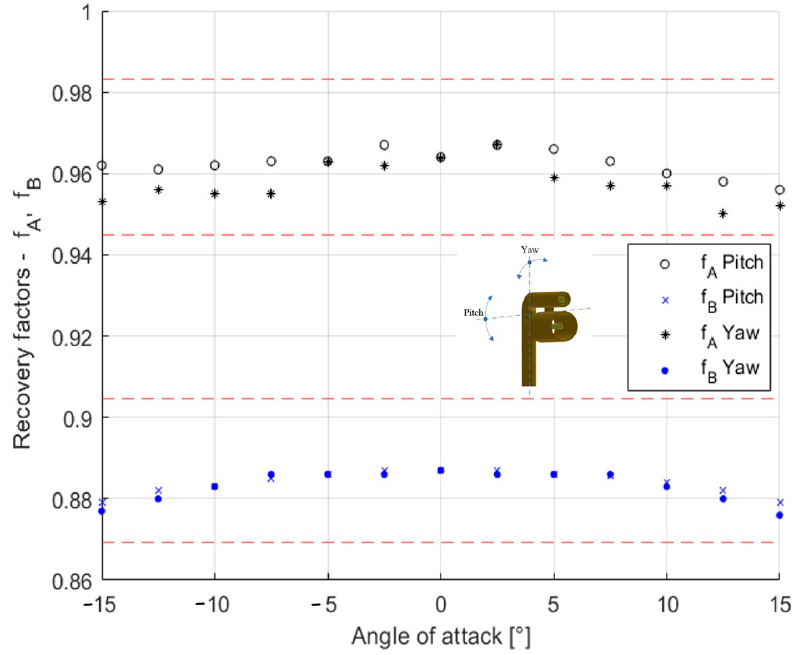
Figure 7. The recovery factors of both temperature sensors as a function of the angle of attack. The 2% insensivity bands are shown by the red dashed lines.